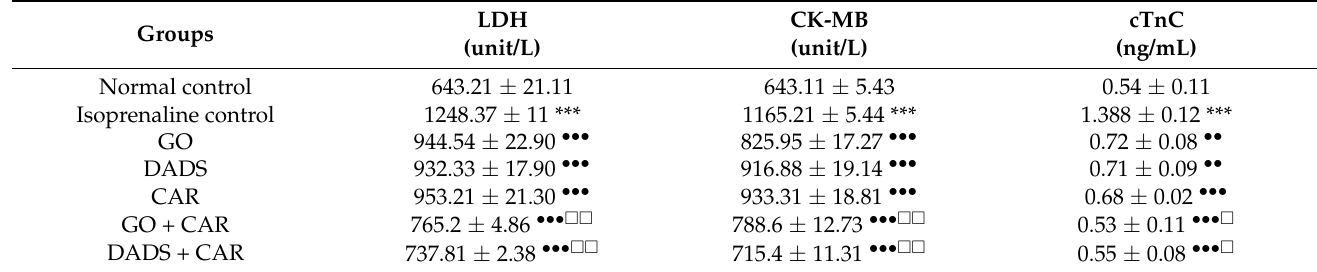
Table 2. Effect on serum cardiac markers.